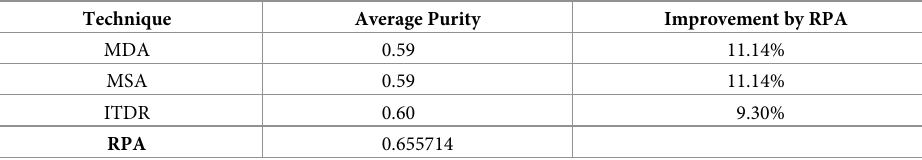
Table 16. Average percentage improvement of Purity by RPA technique.